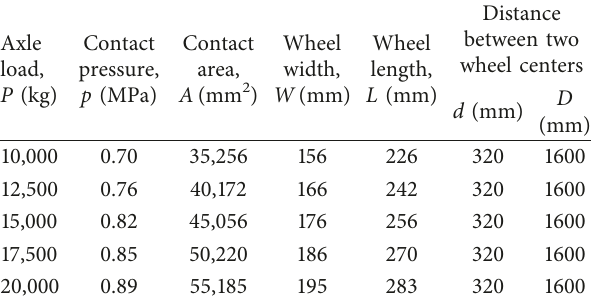
Table 7: Loading parameters of the asphalt pavement